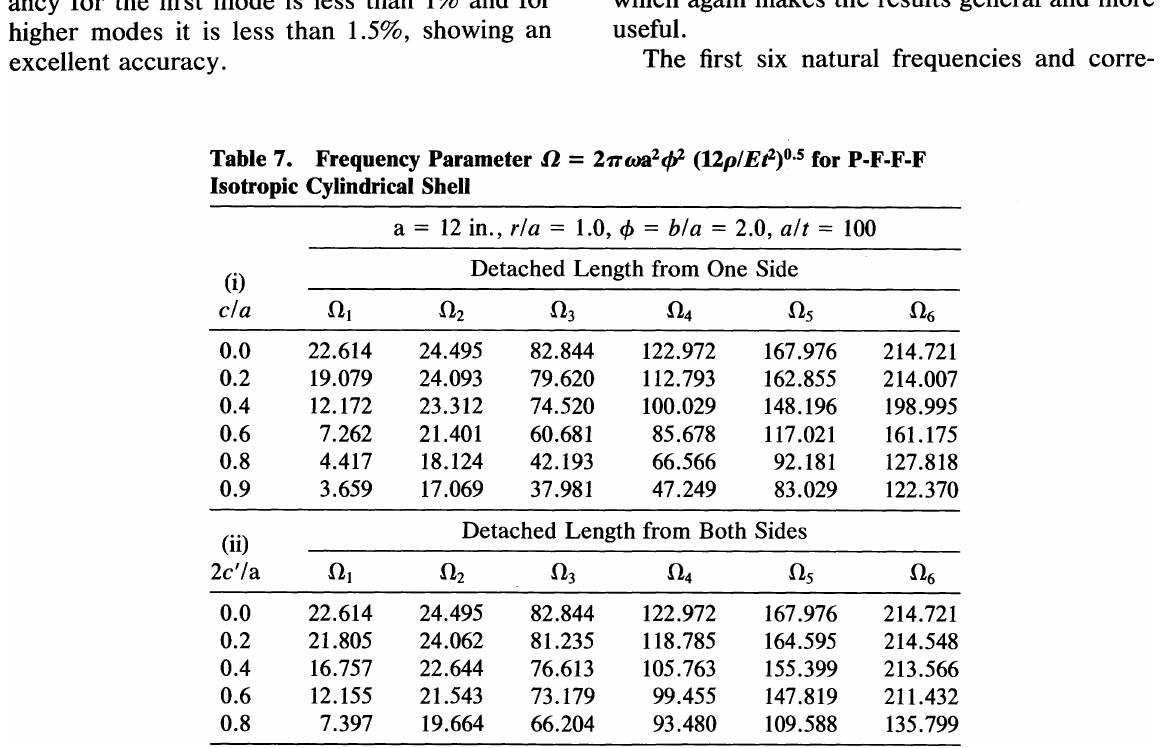
Table 7. Frequency Parameter n Isotropic Cylindrical